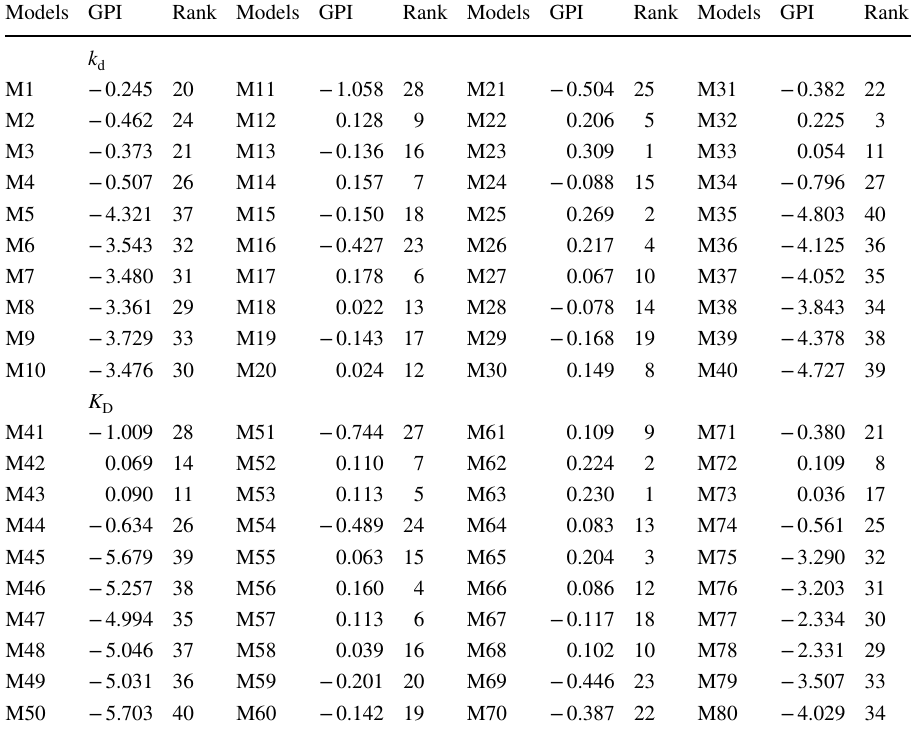
Table 5 The global performance indicator (GPI) and ranking for all proposed